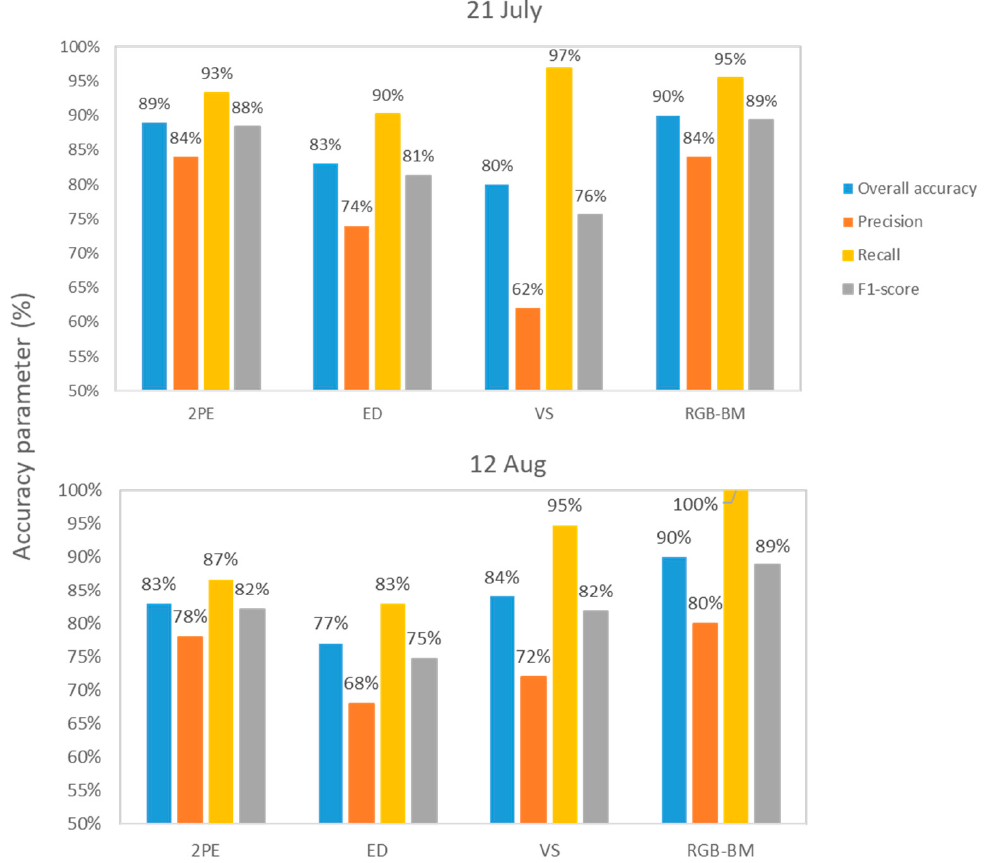
Figure 4. Overall accuracy (blue bars) of canopy/non-canopy classification and precision (red bars), recall (yellow bars), and F1-score (grey bars) parameters of canopy classification as measured with a confusion matrix per date for the 2-pixel erosion (2PE), edge detection (ED), vegetation segmentation (VS), and RGB binary masking (RGB-BM) canopy extraction methods.